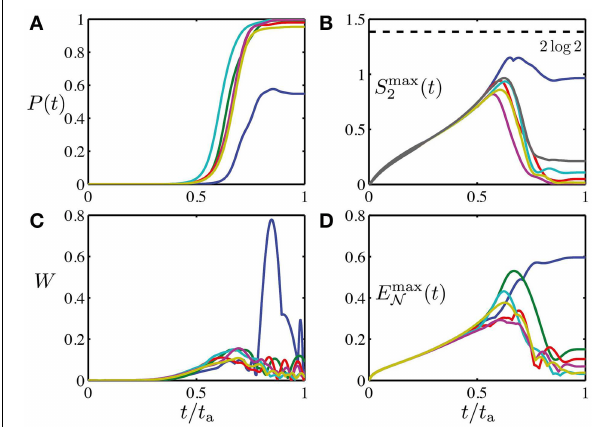
FIGURE 2 | Success probability (A) and entanglement dynamics (B–D) during the adiabatic quantum optimization protocol, for a few instances (shown in different color) of randomly drawn magnetic fields h z i ∈ [ − ǫ z ,ǫ z ] , with ǫ z / J = 1 / 2 . System size is N 16 , for which the chosen = annealing time t a 500 / J is a moderate value. (A) The instantaneous success = probability, i.e., the overlap with the solution of the optimization problem, increases strongly in the vicinity of the equilibrium magnetic phase transition of the homogeneous system. (B) Dynamics of the entanglement entropy S max 2 ( t ) of two spins with the rest, (C) the optimal local entanglement witness W , and (D) the logarithmic negativity E max N ( t ) between pairs of spins. Both S max 2 ( t ) and E max N ( t ) have been obtained by maximization over all possible permutations of two sites on the chain. Easy instances [large P ( t a ) ] are able to reduce the entanglement obtained around the equilibrium phase transition, while hard instances (blue) remain strongly entangled even toward the end of the